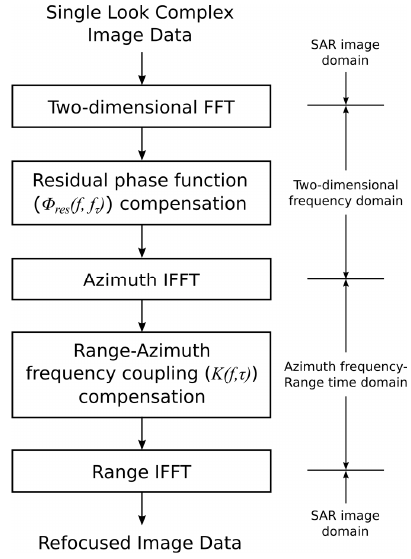
Figure 3. The operations in the proposed correction algorithm, which consists of two phase- multiplications in two different domains. in two different